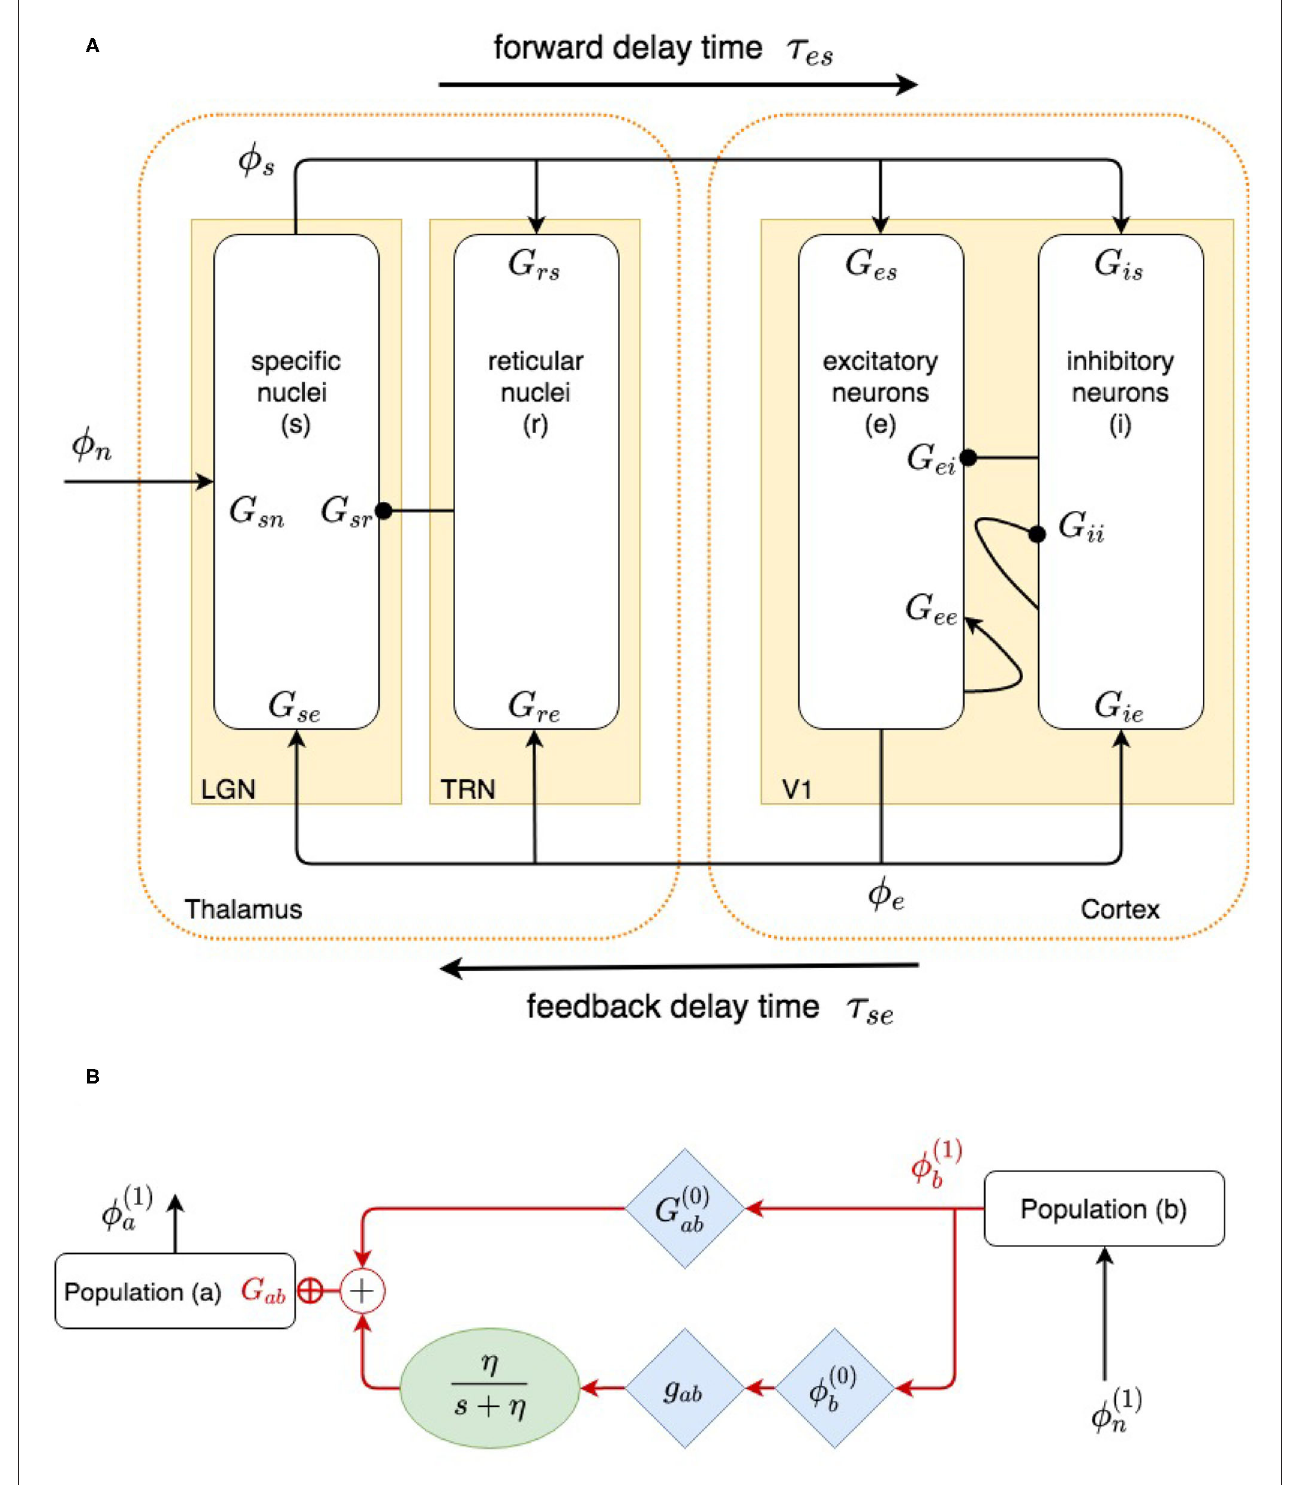
FIGURE 2 | (A) Physiologically based corticothalamic model in which the arrows represent excitatory effects and the circles depict inhibitory ones. The populations are cortical excitatory ( e ) and inhibitory ( i ) neurons, the thalamic reticular nucleus ( r ), thalamic relay neurons ( s ) that project to the cortex, and non-corticothalamic neurons responsible for external inputs ( n ). (B) Schematic of dispersion of neural activity to population a from population b , where modulation of the neuronal gain by local feedback is given by Equation (21).